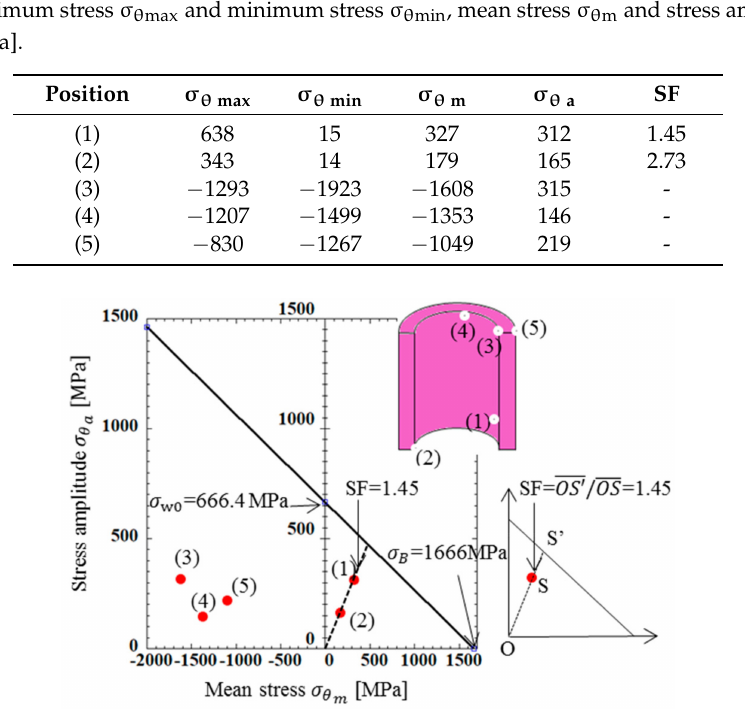
Figure 6. Fatigue limit diagram for bush